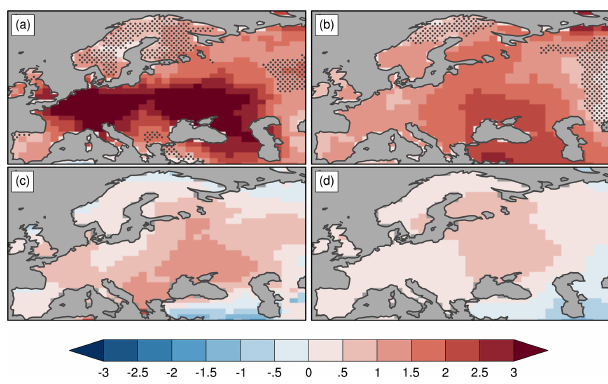
Figure 7. The 1979–2018 summer temperature trend patterns (units: ◦ C every 40 years) for both WE and WA regions based on the HadEX3 dataset: (a) TXx and (b) TNx. Summer (JJA) anomaly dif- ferences (units: ◦ C) between warm and cold periods of AMV. The latter are defined as in O’Reilly et al. (2017): cold periods (1902– 1925 and 1964–1993) and warm periods (1931–1960 and 1996– 2012). The temperature data have been detrended before taking the difference between warm and cold periods. In (a, b) , stippling indi- cates locations where the trend is not significant at the 5%